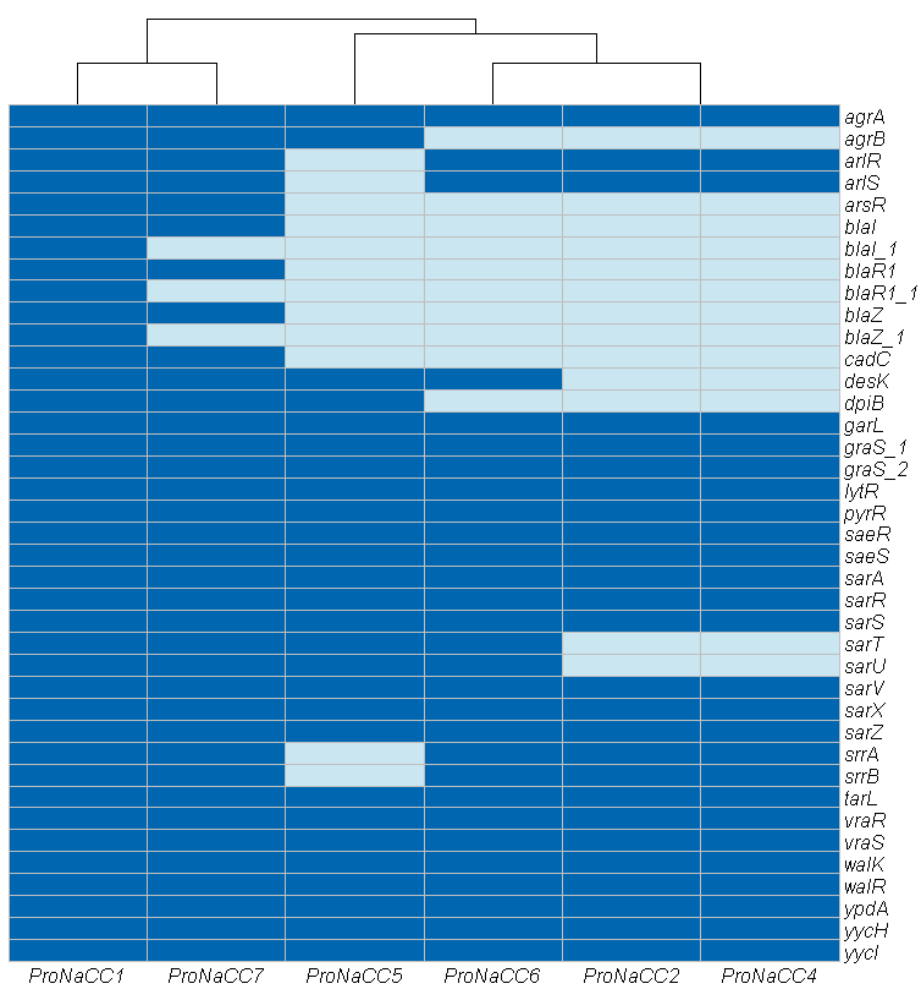
Figure 7. Heat map showing the genes coding for transcriptional regulator factors among the six enterotoxigenic S. aureus strains (dark blue: sequence detected; light blue: sequence not detected).